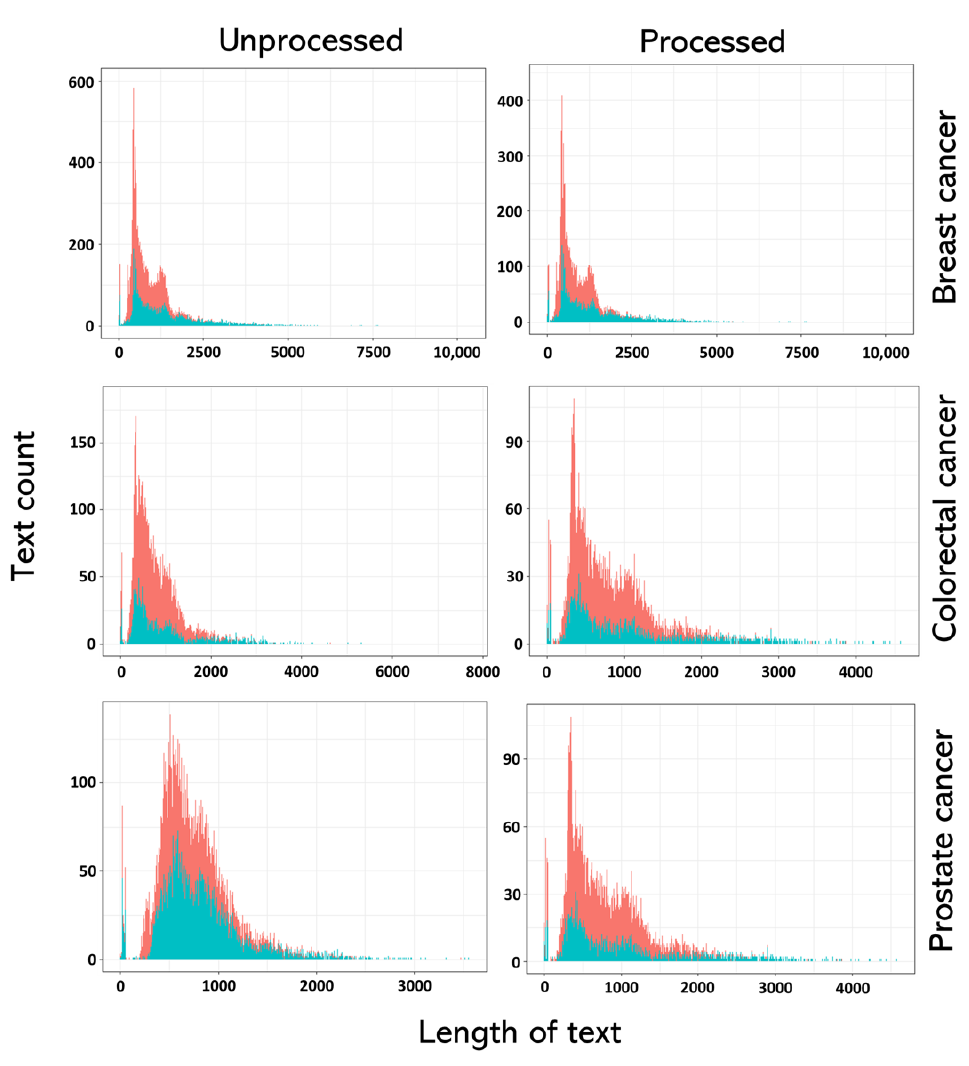
Figure 2. Histogram illustrating frequency counts of pathology report text length for unprocessed and processed benign and malignancy reports for breast ( top ), prostate ( middle ), and colorectal ( bottom ) cancers. The benign class shows higher frequency counts due to large number of cases studied, while the text length of the malignant class is longer than that of the benign class. The text length for each of the cancers was reduced after data